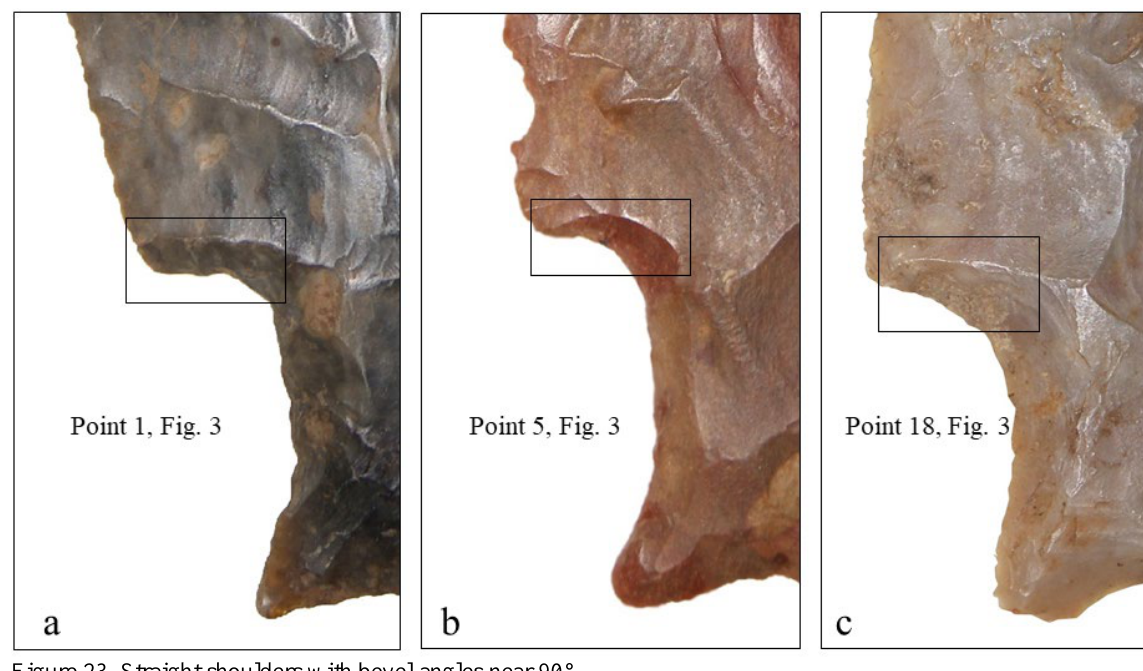
Figure 23. Straight shoulders with bevel angles near 90°.